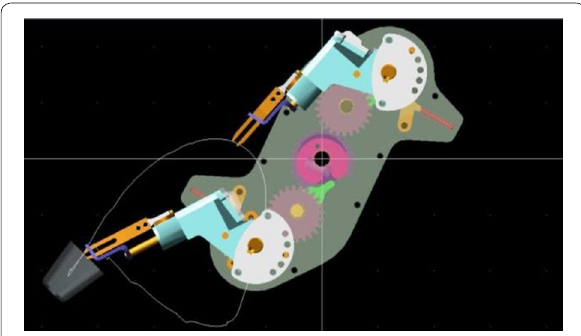
Figure 6 Virtual prototype of the seedling pick-up